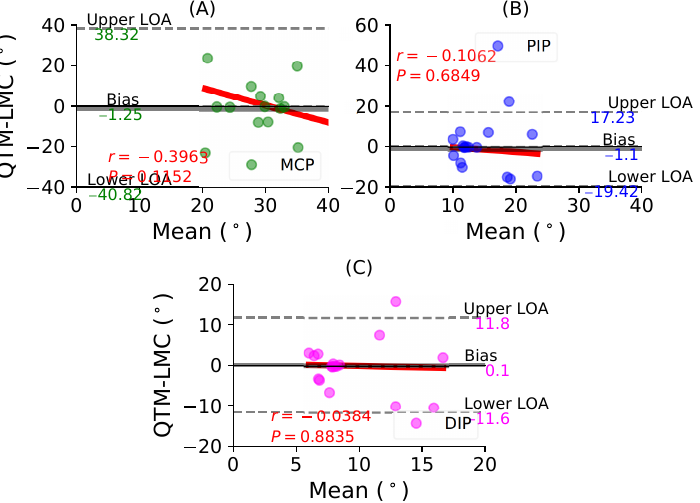
Figure 7. A BA plot of index finger flexion. ( A ) MCP joint, ( B ) PIP joint and ( C ) DIP joint. Figure 8A shows a BA plot for the MCP joint with a positive bias of 10.67 ◦ with r = 0.0116, P = 0.9646. Figure 8B shows a positive bias of 14.92 ◦ with r = 0.9062, P < 0.001 fir the PIP joint. Lastly, Figure 8C shows a negative bias of 3.51 ◦ with r = 0.4352, P = 0.0815 for the DIP joint. During the middle finger flexion movement, the PIP joint demonstrated the highest positive correlation between the two